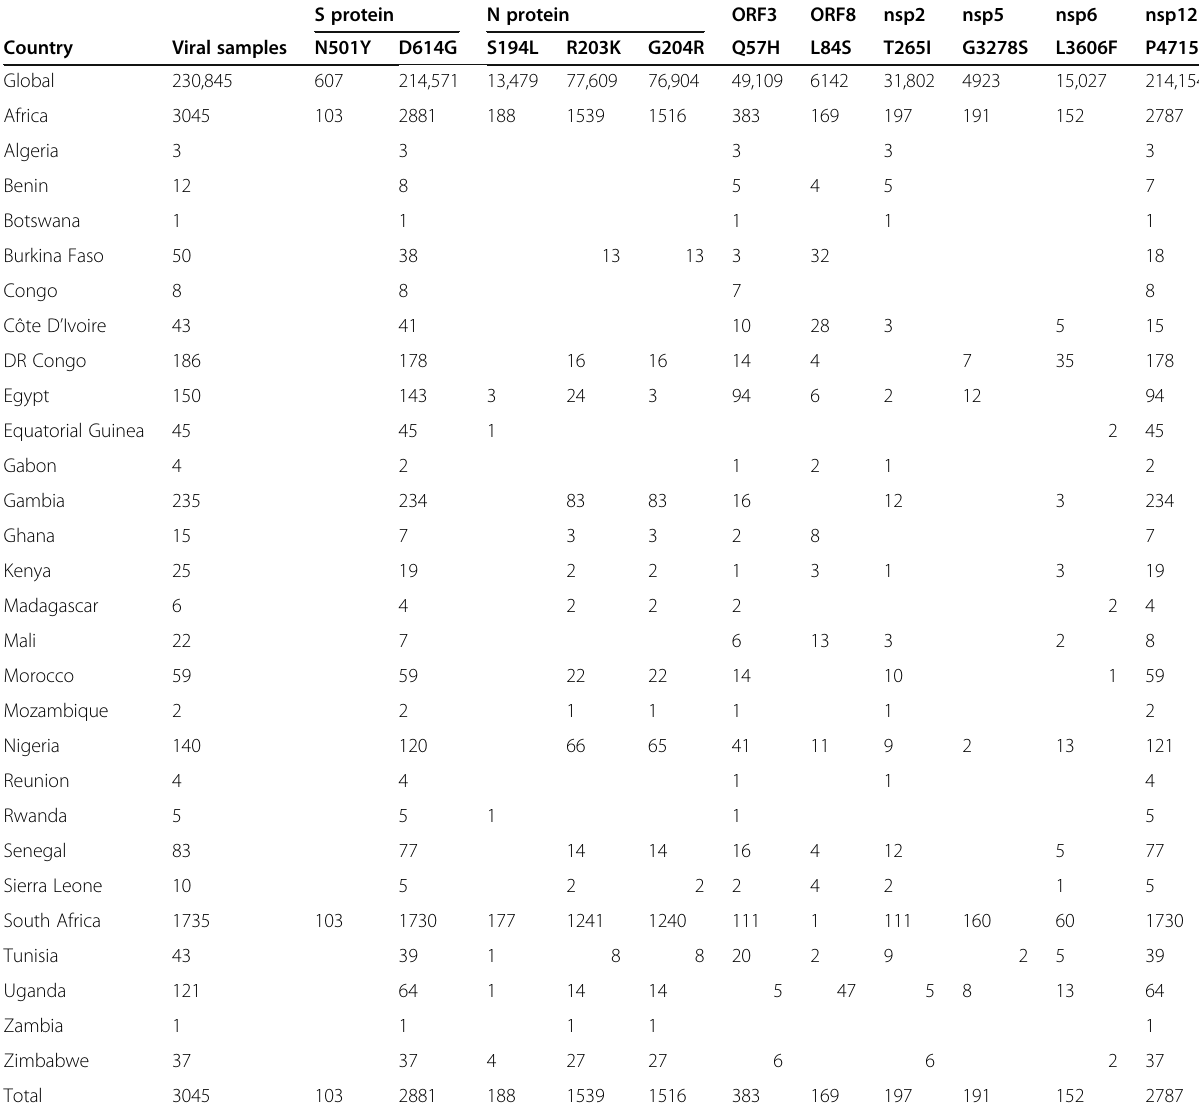
Table 1 Recurrent mutation distribution in the SARS-CoV-2 genome in African population S protein N